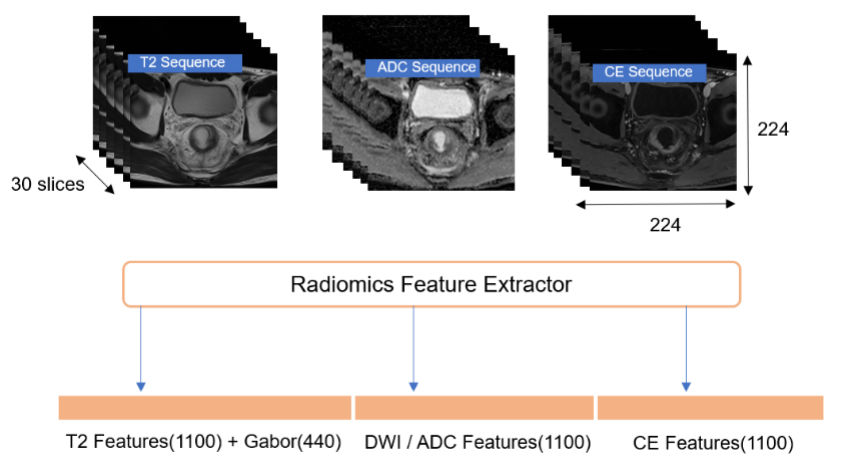
Figure 4. Radiomics feature